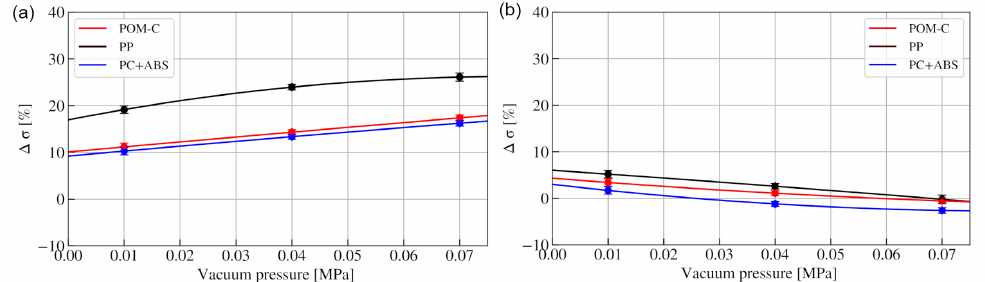
Figure 5. Increase in stress in compression ( a ) and tension ( b ) expressed as percentage in a function of vacuum pressure.